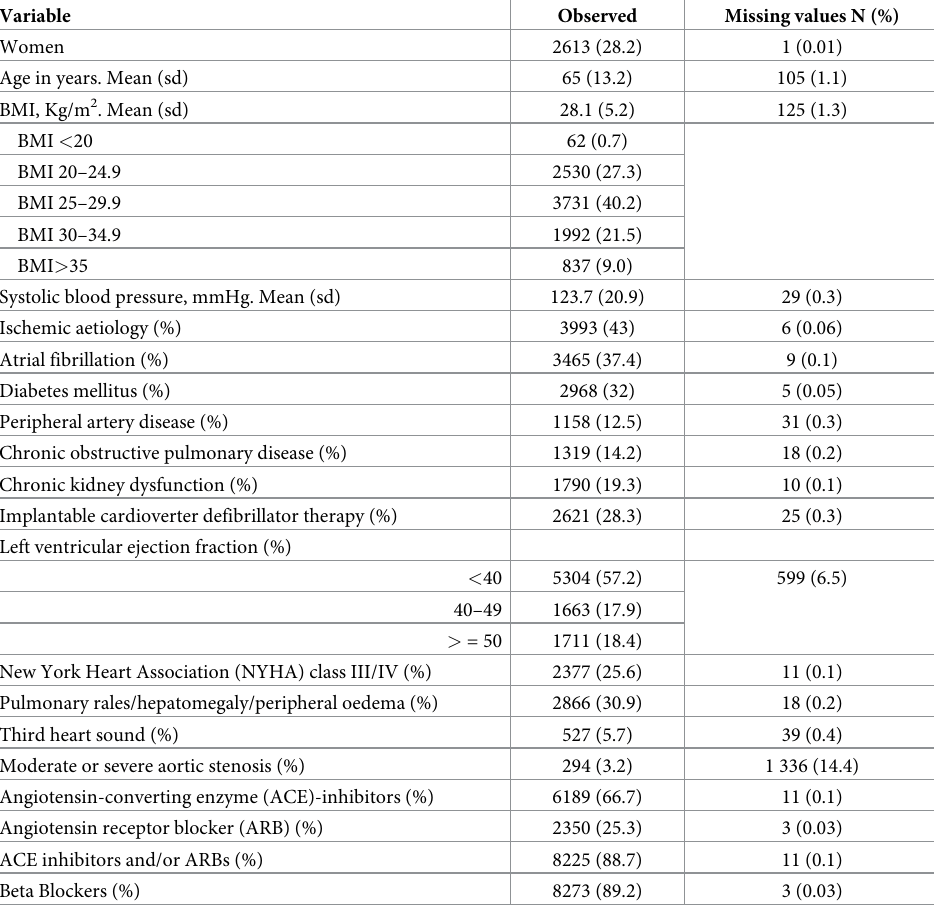
Table 1. Baseline characteristics of the study population. Variable